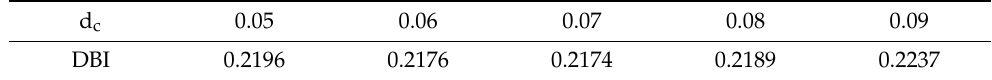
Table 3. DBI of different cutoff